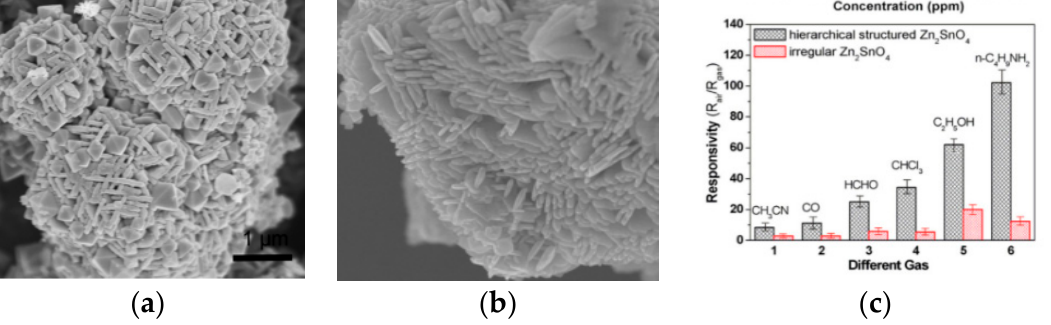
Figure 7. SEM images of ( a ) quasi-microspheres [22] ( b ) cube-like structures [29] ( c ) responsivity of Zn 2 SnO 4 -based sensors to different testing gases. The working temperature was kept at 350 °C (relative humidity: 50%) [29].